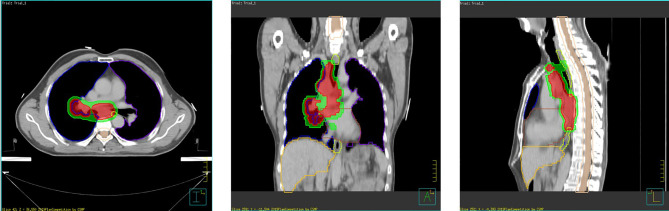
Case presentation—axial, sagittal, and coronal views.